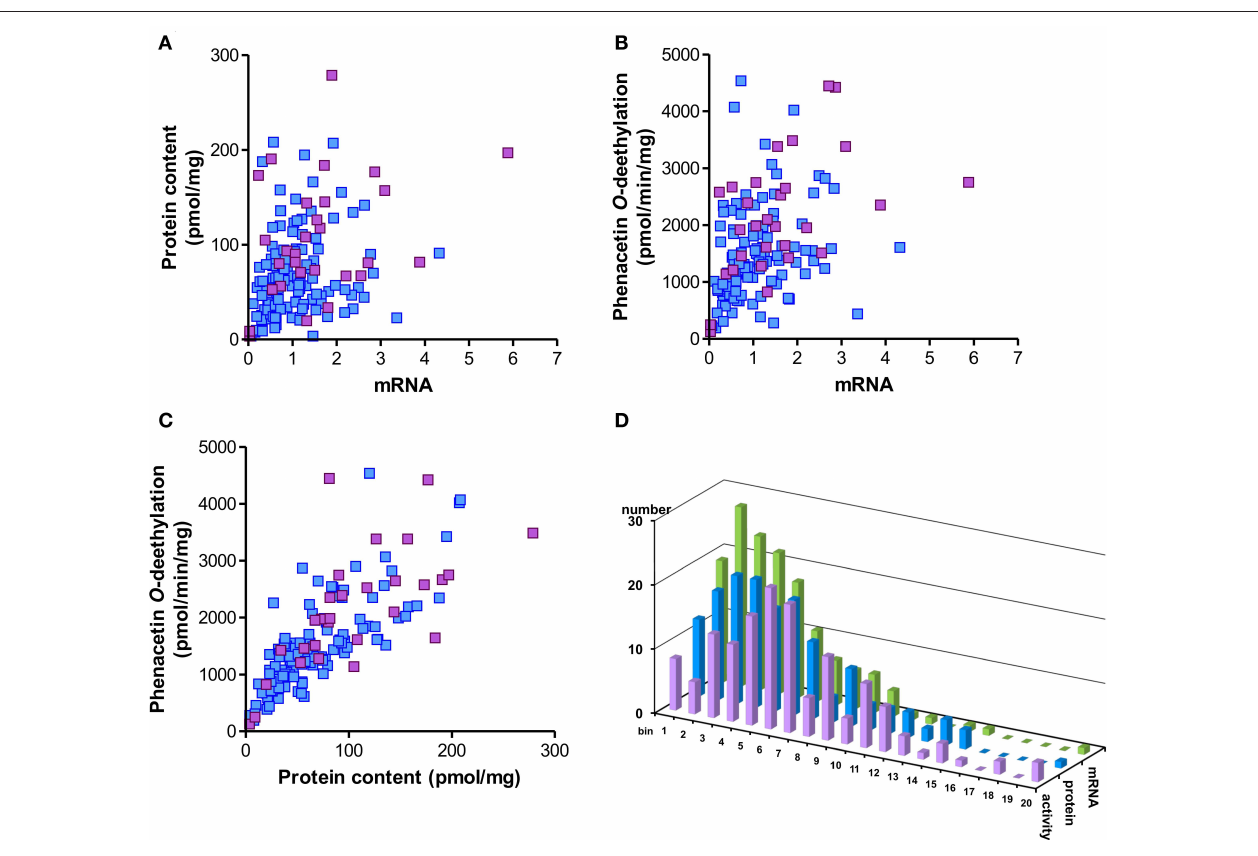
Figure 2 | Spearman correlations and population distribution of hepatic CYP1A2 phenotypes. CYP1A2 mRNA was determined by a specific TaqMan real-time RT-PCR assay, protein was determined by Western blot and enzyme activity was measured by LC-MSMS analysis of phenacetin- O -deethylation in human liver microsomes ( n = 150). Results are means of duplicate